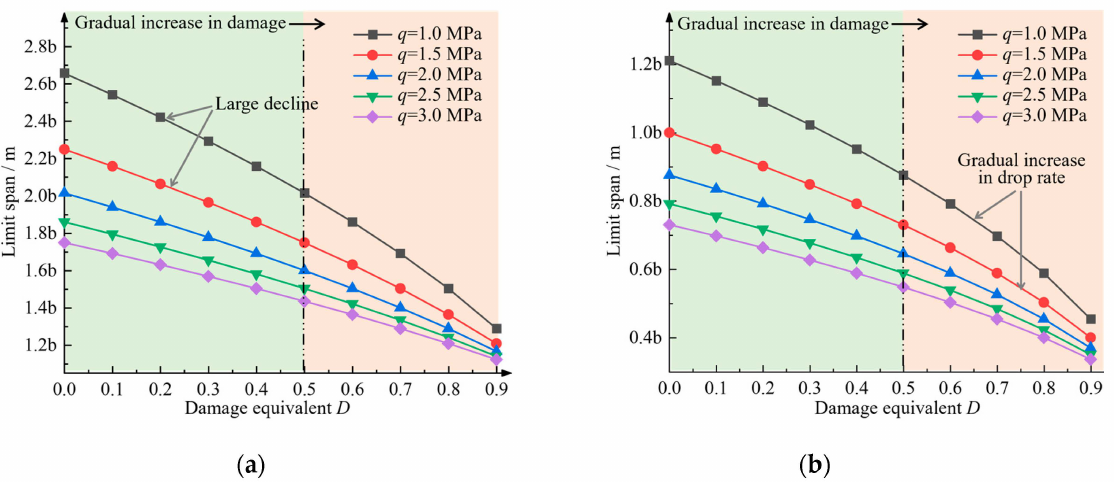
Figure 5. Relationship between damage degree and first and periodic fracture intervals of the main roof. ( a ) First fracture of the damaged main roof ( b ) Periodic fracture of the damaged main